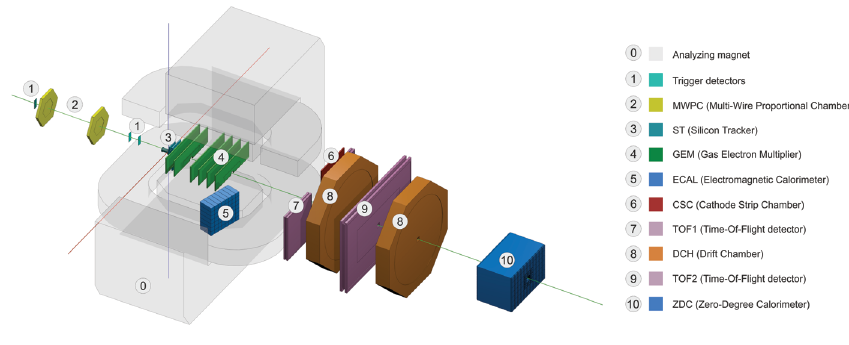
Figure 1. View of the experimental setup in the last run